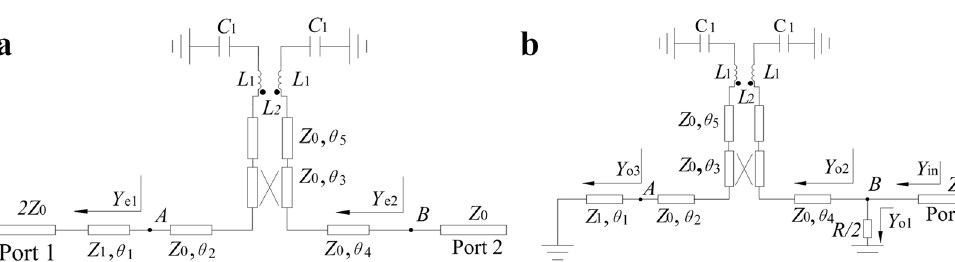
Figure 4. Equivalent circuit ( a ) even mode ( b ) odd